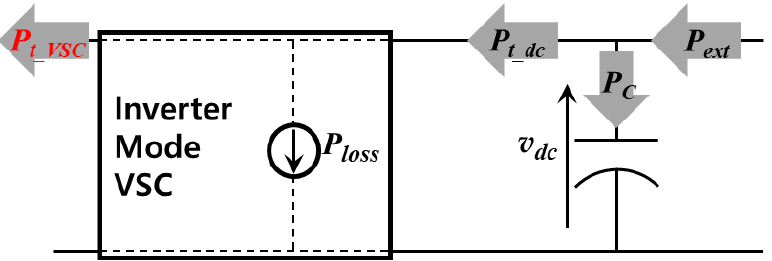
Figure 7. DC Link Voltage Control of Inverter Mode VSC (Voltage-Sourced Converter).